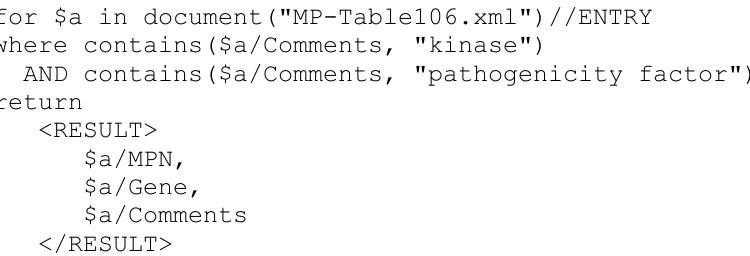
Fig. 4: Example of a QUILT-query in the context of our annotation